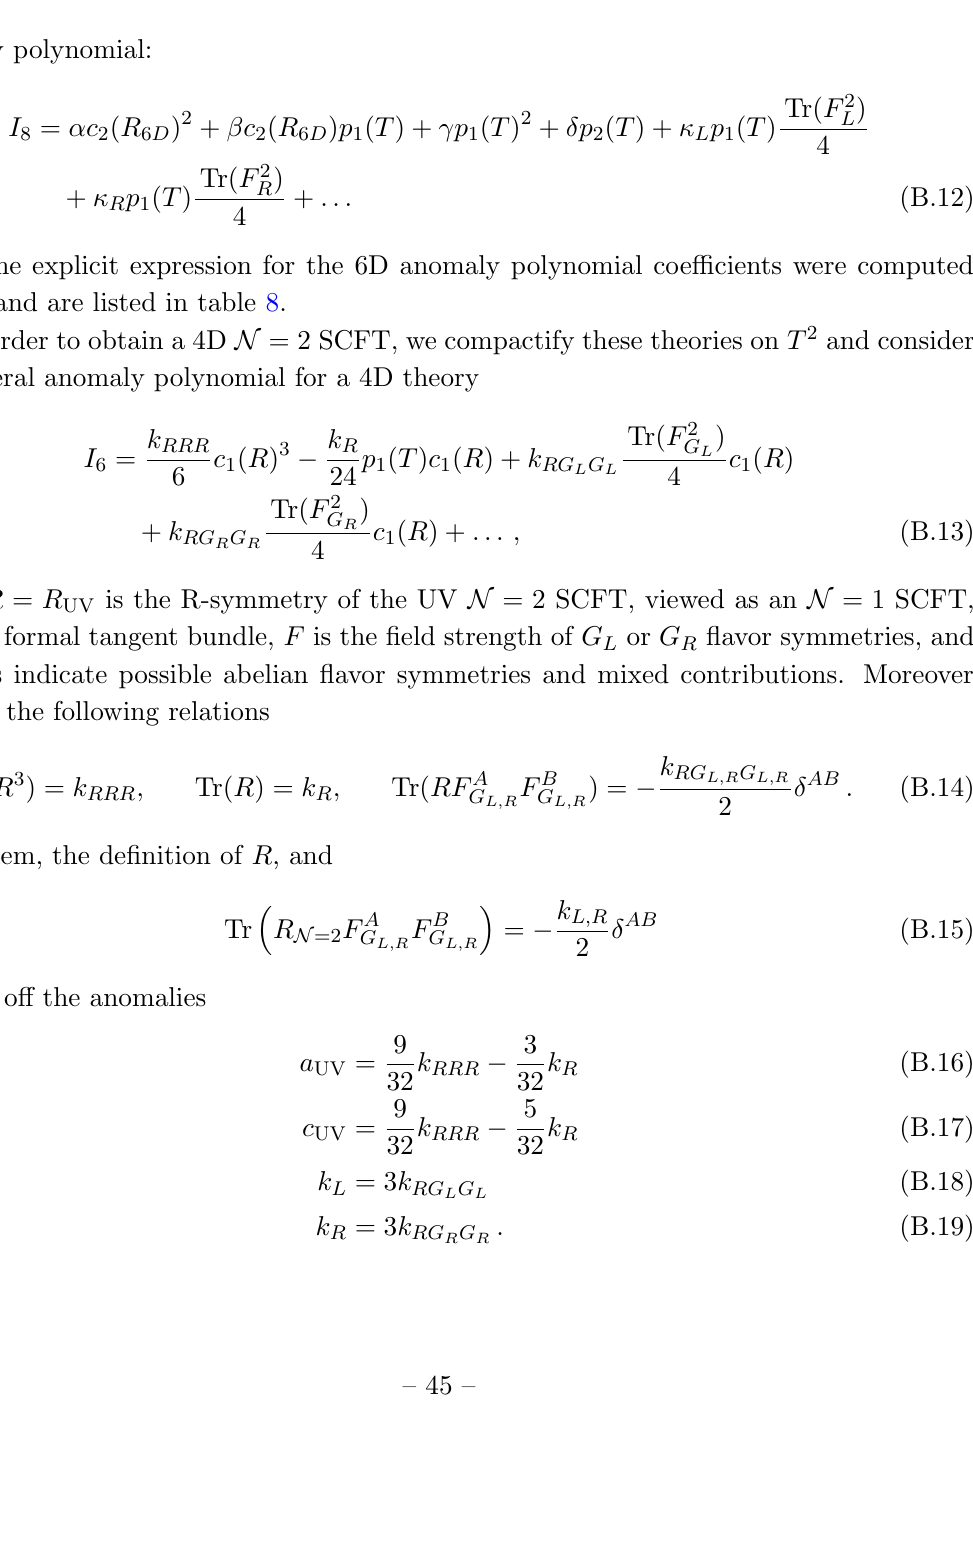
Table 8. Coe(cid:14)cients of 6D anomaly polynomial